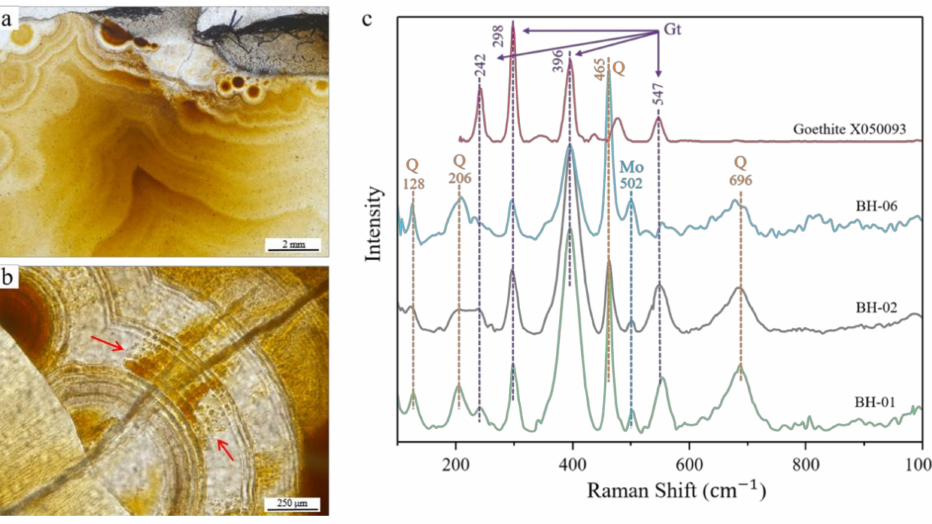
Figure 6. ( a , b ) Microscopic characteristics under polarised optical microscopy. The red arrows in figure ( b ) indicate the distribution of chromogenic minerals along the strips. ( c ) Raman spectra of the ferruginous particles. The peak positions of ferruginous particles are similar to that of the goethite numbered X050093 in the RRUFF Raman database. The peaks of Gt, Q, and Mo are indicated by purple, yellow and blue dashed vertical lines,